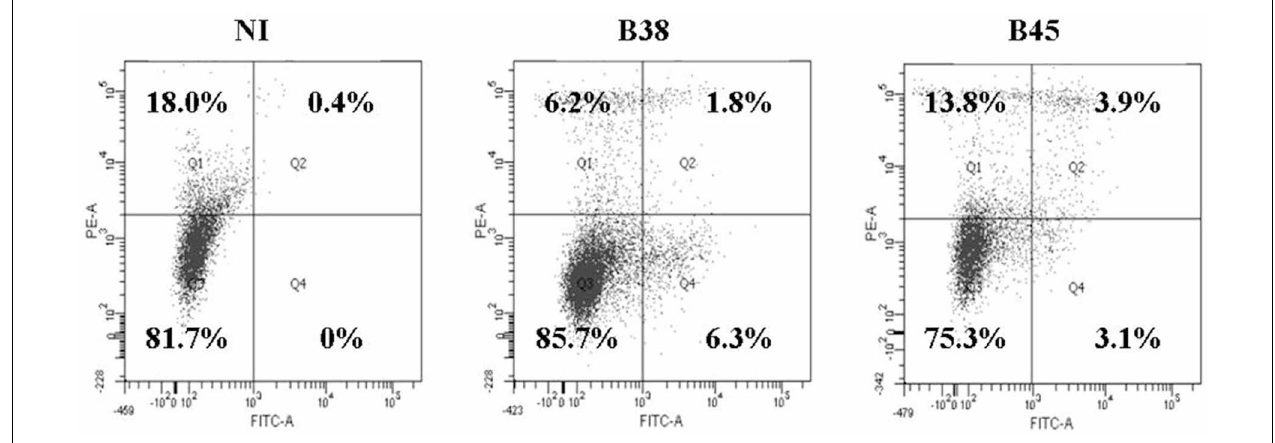
FIGURE A3 | Apoptosis rate in dendritic cell apoptosis activated by H. pylori . DCs were cocultivated for 48h with B38 or B45 H. pylori strain at MOI 1. The cells were labeled with anti-annexin V-FITC antibody and propidium iodure and analyzed by flow cytometry. Percentages of viable DCs (double negative cells in Q3), necrotic DCs